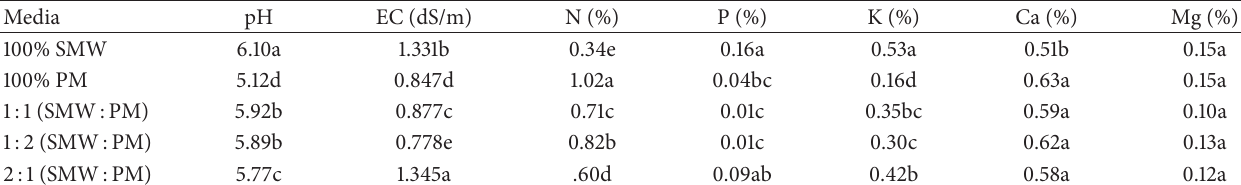
Table 1: Chemical composition of study